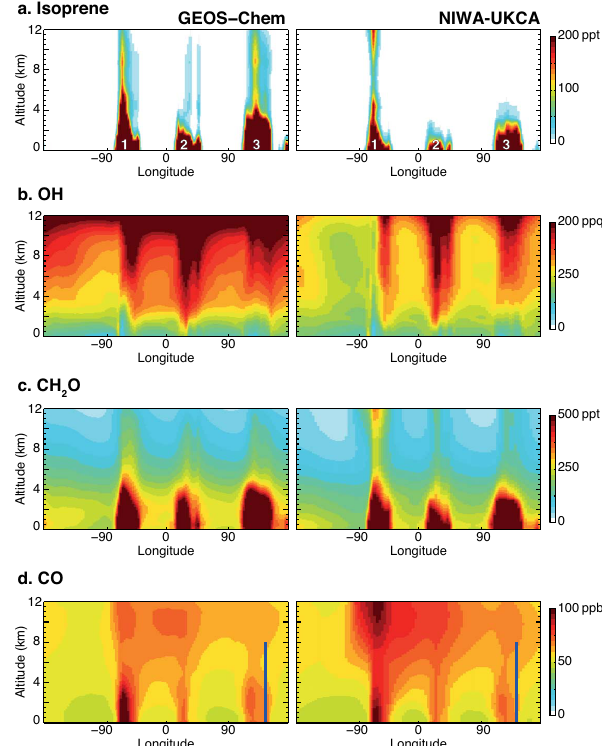
Figure 9. Five-year mean DJF longitude–altitude cross sections averaged over 15–45 ◦ S of (a) isoprene, (b) OH, (c) CH 2 O, and (d) CO as simulated by GEOS-Chem (left) and NIWA-UKCA (right). Numbers in (a) correspond to locations of continental source regions: 1 = South America, 2 = Africa, 3 = Australia. The blue lines in (d) show the location and vertical extent of the CGOP air- craft